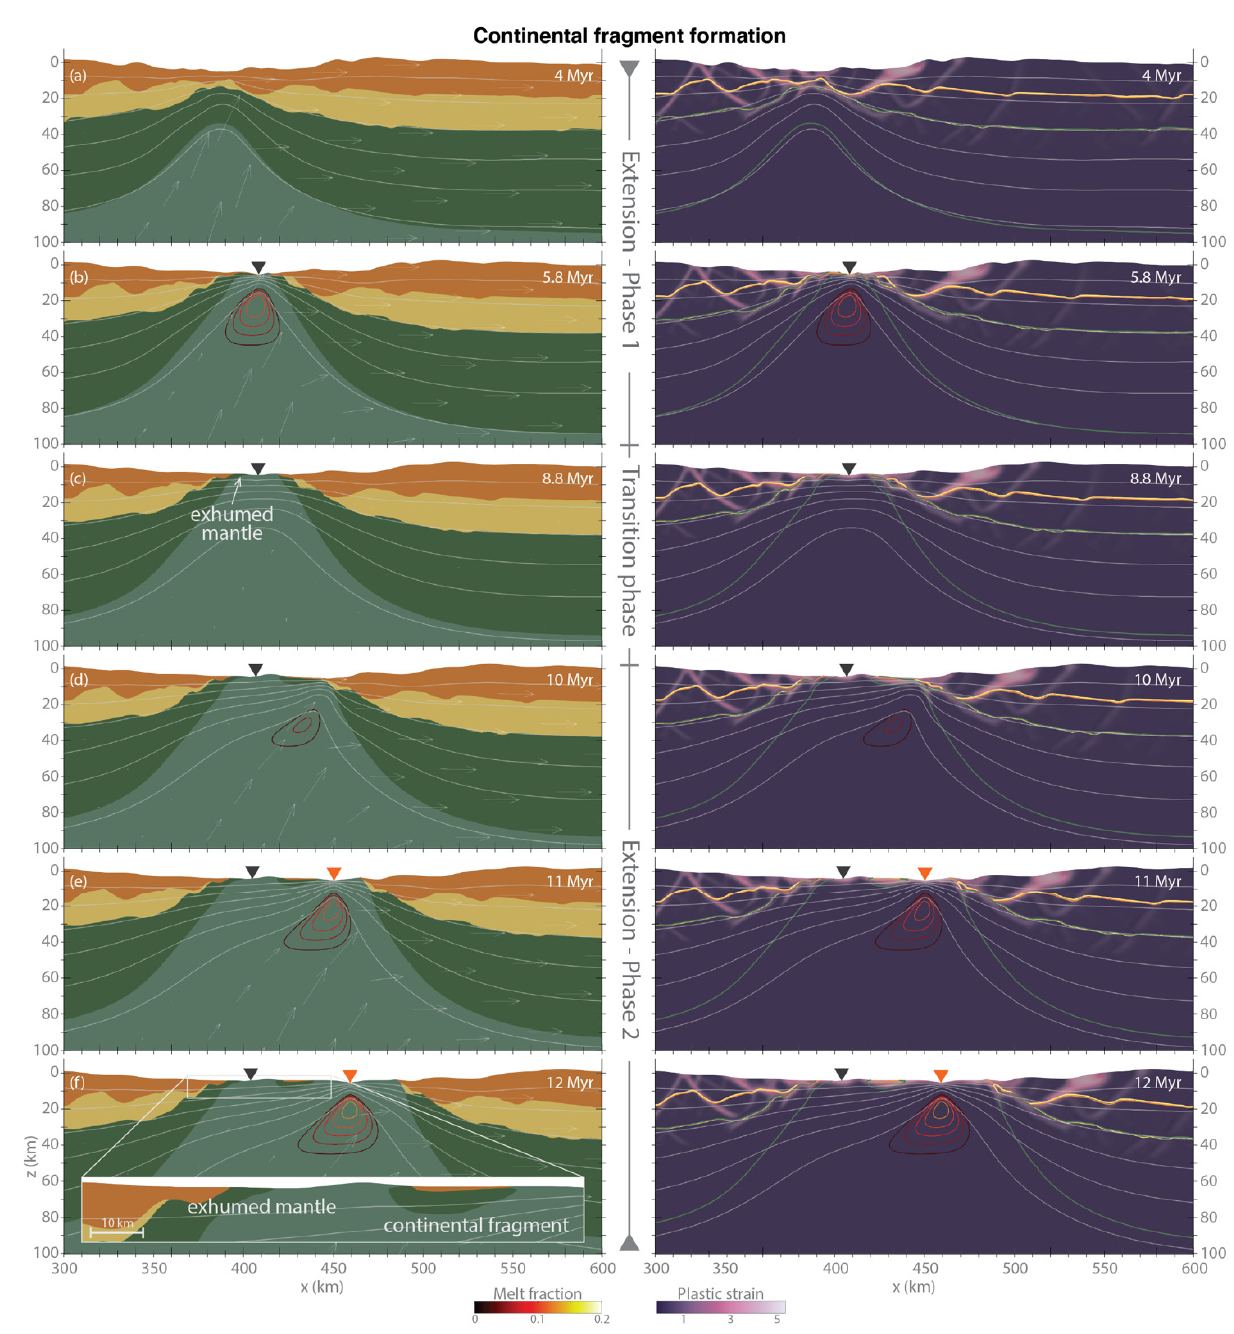
Figure 4. Continental fragment formation. Evolution of model with v 1 = 2 cm/yr, v 2 = 2 cm/yr, and t 1 = 6 Myr. Left column shows the compositional field (see Figure 2 for legend) and right column shows the non-initial plastic strain field. During the first phase of extension ( a ) the lithosphere thinness and ( b ) continental break-up, exhumation of lithospheric mantle on the left margin, and formation of a spreading ridge occur. ( c ) Pause in extension, from 6 to 9 Myr, tapers melt production, until no melt is formed. ( d ) After extension is resumed adiabatic decompression melting starts again and ( e , f ) a new spreading ridge forms closer to the trench. At the end of the model, the basin is made, from left to right, of exhumed mantle material, an abandoned spreading ridge, a continental fragment of upper crust and lithospheric mantle, and a new spreading ridge that produces new oceanic crust. When melt is present, contours of melt fraction are shown. Isotherms are plotted every 200 ° C. Black triangles show the location of the first spreading ridge, while orange triangles show the location of the spreading ridge during the second phase of extension. Figure S3 in the supplementary material shows the effective viscosity for the same time steps.